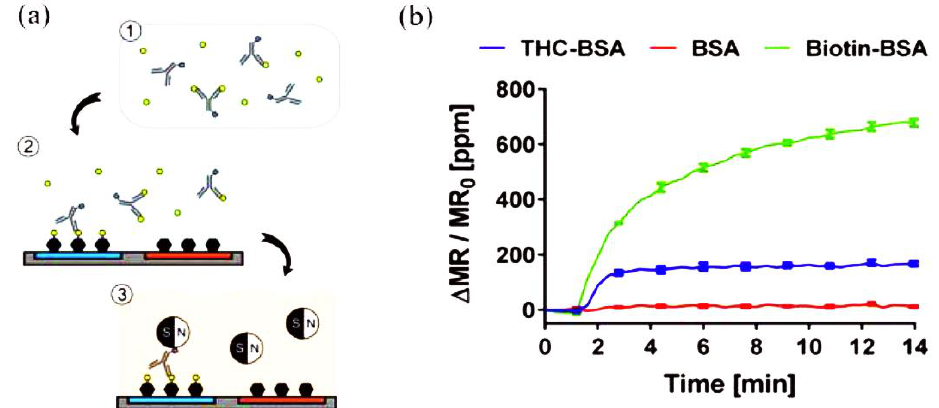
Figure 3. Schematic representation of the GMR biosensing platform for THC: ( a ) 1: biotinylated anti-THC antibodies were incubated with THC-containing samples. 2: the mixture was injected on a chip with immobilized bovine serum albumin (BSA) and THC–BSA bioconjugate, to allow the antibodies to bind. 3: Streptavidin-coated MNPs were added to the chip to communicate the signals. ( b ) Representation of the measured signals of THC-BSA, BSA, and biotinylated BSA (Biotin-BSA) immobilized on different sensors. Adapted with permission from [75]. Copyright (2016) American Chemical Society.